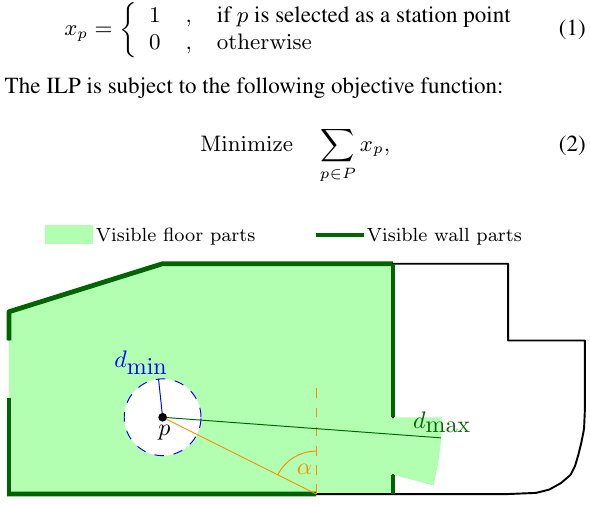
Figure 2. Visibility polygon from a position p . Minimal and maximal range, incidence angle as well as obstacles are considered, adapted from Dehbi et al.